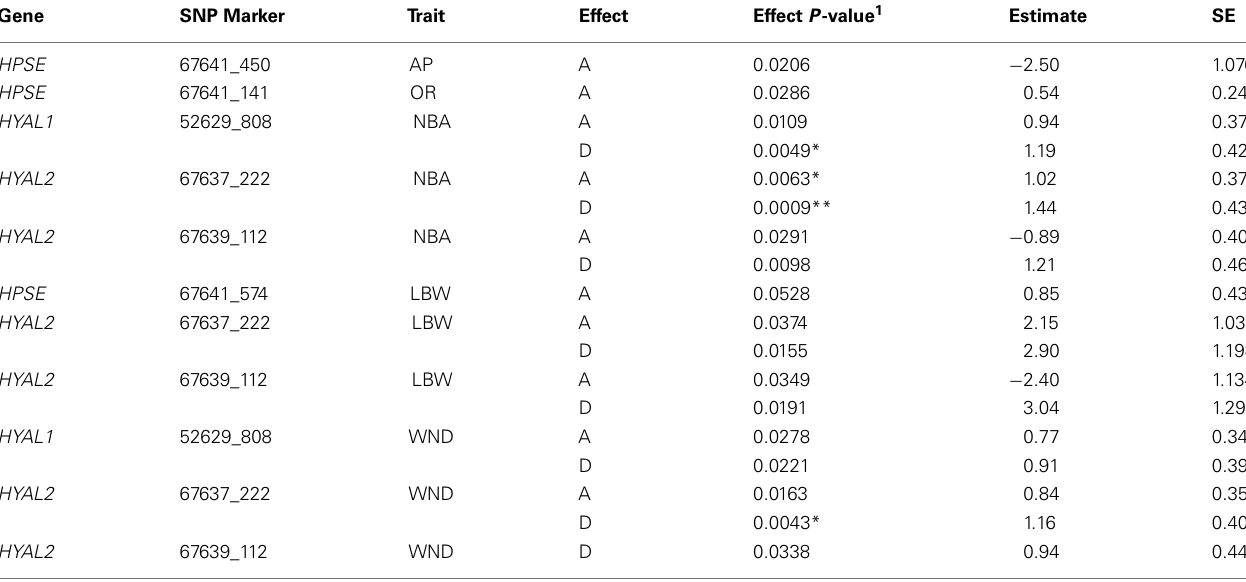
Table 4 | Single trait association analysis of SNP with reproduction and production performance traits in a LDY swine population. Gene SNP